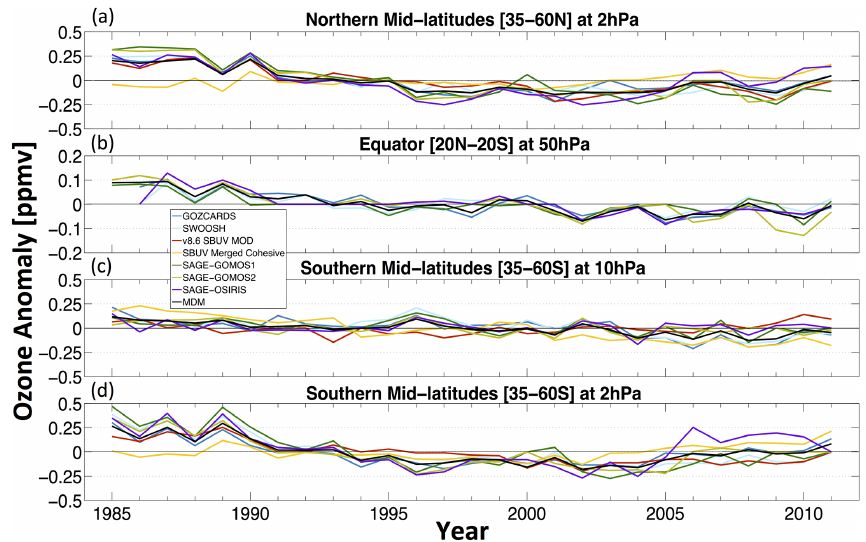
Figure 7. Annual mean anomalies for (a) the Northern Hemisphere mid-latitudes (35–60 ◦ N) at 2hPa, (b) the tropics (20 ◦ N–20 ◦ S) at 50hPa, and (c) the Southern Hemisphere mid-latitudes (35–60 ◦ S) at 10hPa. Annual averages are only shown if data for more than 7 of 12 months per year were available. Note the different y -axis